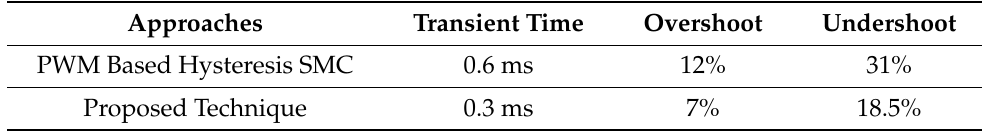
Table 4. Comparison of the simulation results.